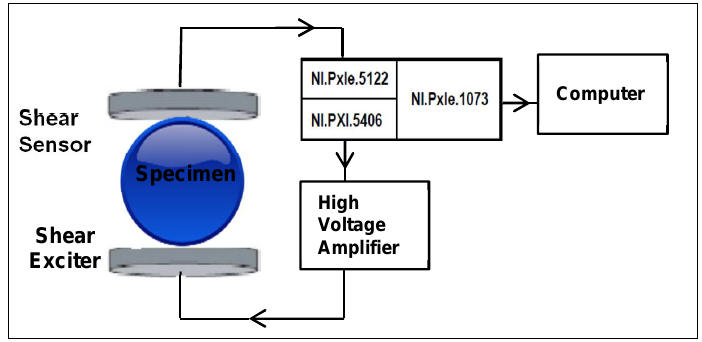
Figure 1. The first vibration spectroscopy experiment using shear wave transducers. The diagram depicts the setup